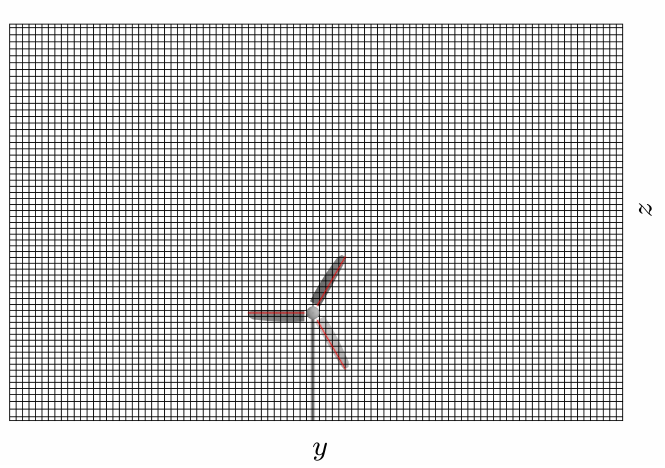
z plane. The rectangular cells are for fluids. −